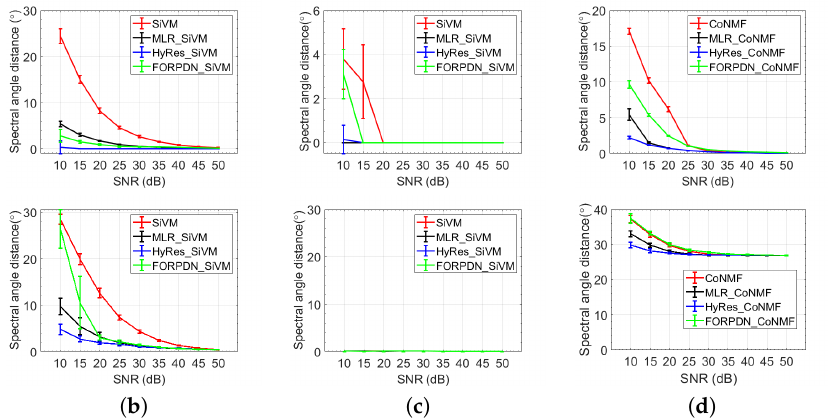
Figure 9. The quality of the estimated/extracted endmembers in terms of spectral angle distance (SAD) in degrees on the simulated data (top row) and Samson data (bottom row) for colored noise ( η = 18): ( b ) extracted endmembers; ( c ) library endmembers; ( d ) estimated